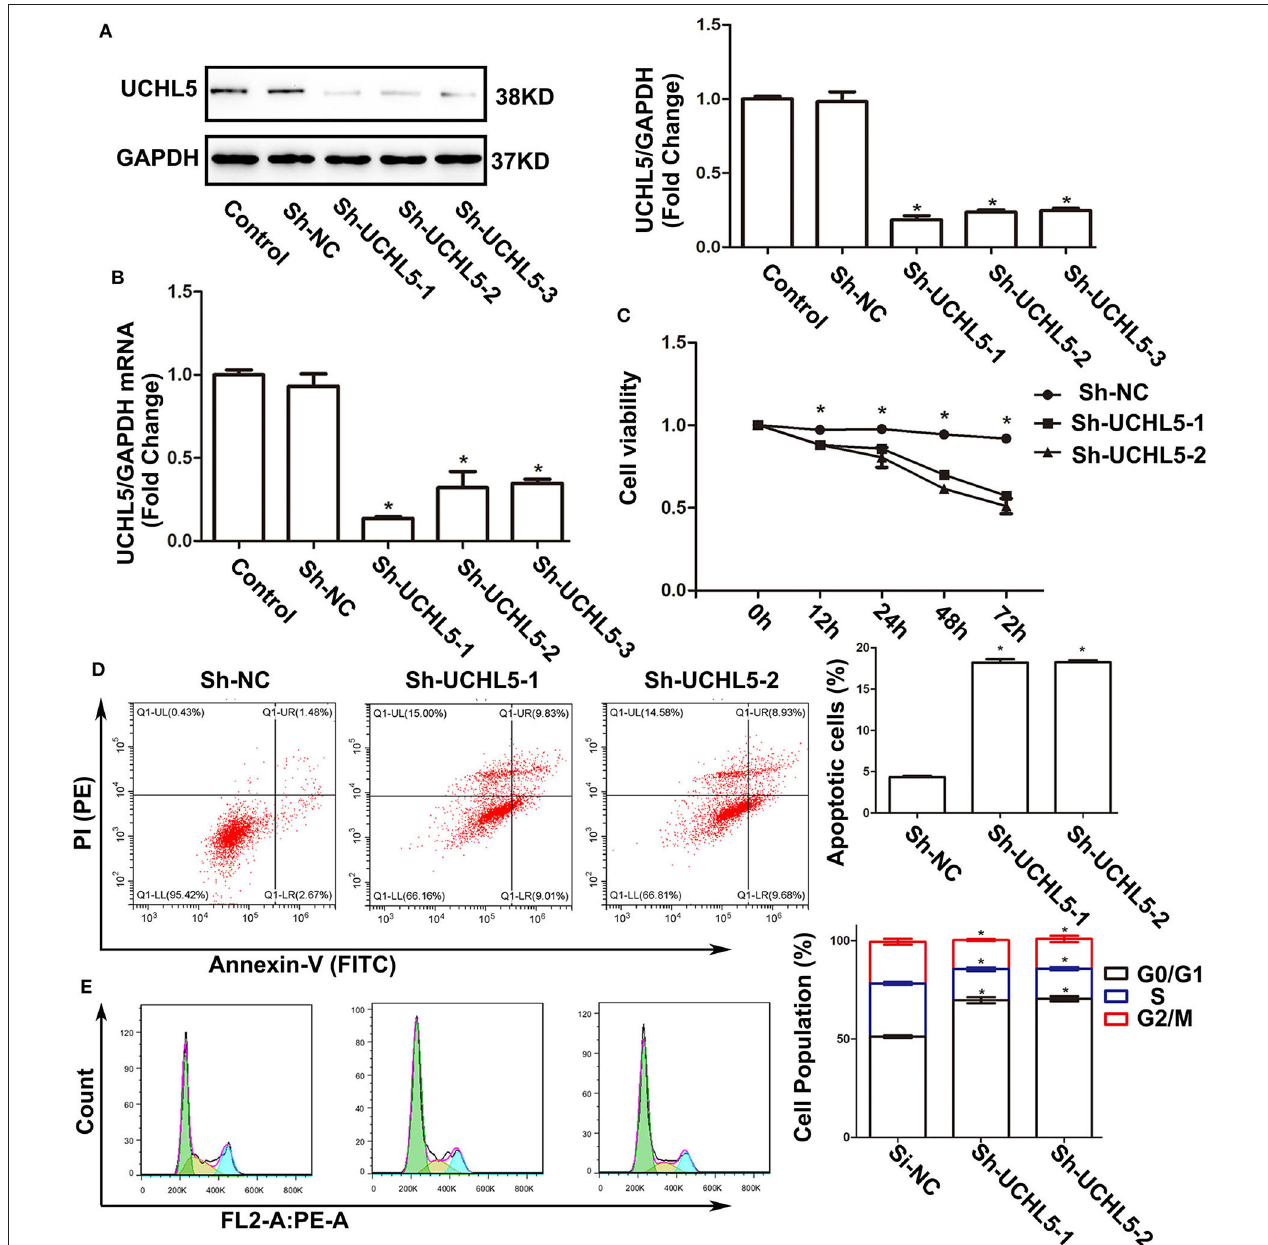
FIGURE 3 | UCHL5 knockdown decreased cell viability, increased apoptosis, and arrested cell cycle in HCE-1-A endometrial cancer cells. (A) The levels of UCHL5 were detected by WB in HCE-1-A cells at 48h after shRNA lentiviral infection ( N = 3 times). * P < 0.05 vs. control. (B) Relative mRNA levels of UCHL5 in shRNA lentiviral infected HCE-1-A cells ( N = 3). * P < 0.05 vs. control. (C) Relative cell viability was detected by CCK-8 at different time points ( N = 3). * P < 0.05 vs. sh-UCHL5-1 and sh-UCHL5-2. (D) Apoptosis cells were marked by Annexin V-FITC/PI, and the percentage was analyzed by flow cytometry in HCE-1-A cells at 48h after shRNA lentiviral infection ( N ≥ 3). * P < 0.05 vs. sh-NC (negative control). (E) Cell cycle was measured by Cell Cycle Analysis Kit ( N ≥ 3). * P < 0.05 vs.